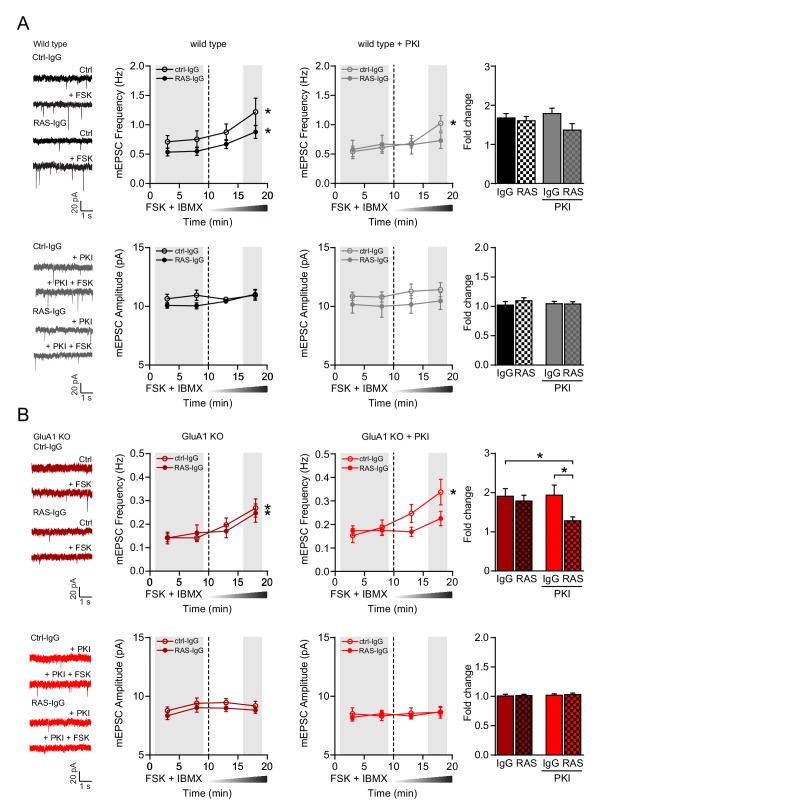
cAMP activates GluA2/3-plasticity through a PKA- and Ras-dependent signaling pathway.(A–B) Miniature EPSC recordings with anti-Ras IgG or control IgG in recording pipette from CA1 neurons in brain slices acutely isolated from mature wild type and GluA1-KO mice. After ten minutes baseline recording to allow antibody to perfuse into the cell, forskolin and IBMX were washed in the extracellular solution. (A) Upon the wash-in of forskolin, WT neurons showed an increase in mEPSC frequency in the presence of control IgG (paired t-test, p<0.001) and anti-Ras IgG (paired t-test, p<0.001), but not in mEPSC amplitude (paired t-test, ctrl-IgG: p=0.7; RAS-IgG: p=0.055). Stars indicate a significant increase at 15–20 min compared to the 10 min baseline. In the presence of PKI, the wash-in of forskolin led to a significant increase in frequency in neurons perfused with control IgG (paired t-test, p=0.007), but not with Ras IgG (paired t-test: p=0.07). Comparisons between the fold changes did not yield significant results (ANOVA, p=0.12; IgG: n=7; Ras: n=9; IgG/PKI: n=10; Ras/PKI: n=9). (B) In GluA1-deficient neurons, the wash in of forskolin also increased mEPSC frequency regardless of the antibody (paired t-test, ctrl-IgG: p<0.001; Ras-IgG: p<0.0001). mEPSC amplitudes were not affected by forskolin (paired t-test, ctrl-IgG: p=0.7; Ras-IgG: p=0.3). In the presence of PKI neurons perfused with control IgG show a significant increase in frequency upon the wash in of forskolin (paired t-test, p=0.006). In neurons with Ras-IgG this potentiation was absent (paired t-test: p=0.15). The fold increase in mEPSC frequency is blocked by the anti-Ras antibody in the presence of PKI in GluA1-KO neurons (ANOVA, IgG/PKI vs Ras/PKI: p=0.03; IgG vs Ras/PKI: p=0.04; IgG: n=11; Ras-IgG: n=12; IgG/PKI: n=10; Ras-IgG/PKI: n=14). Error bars indicate SEM.